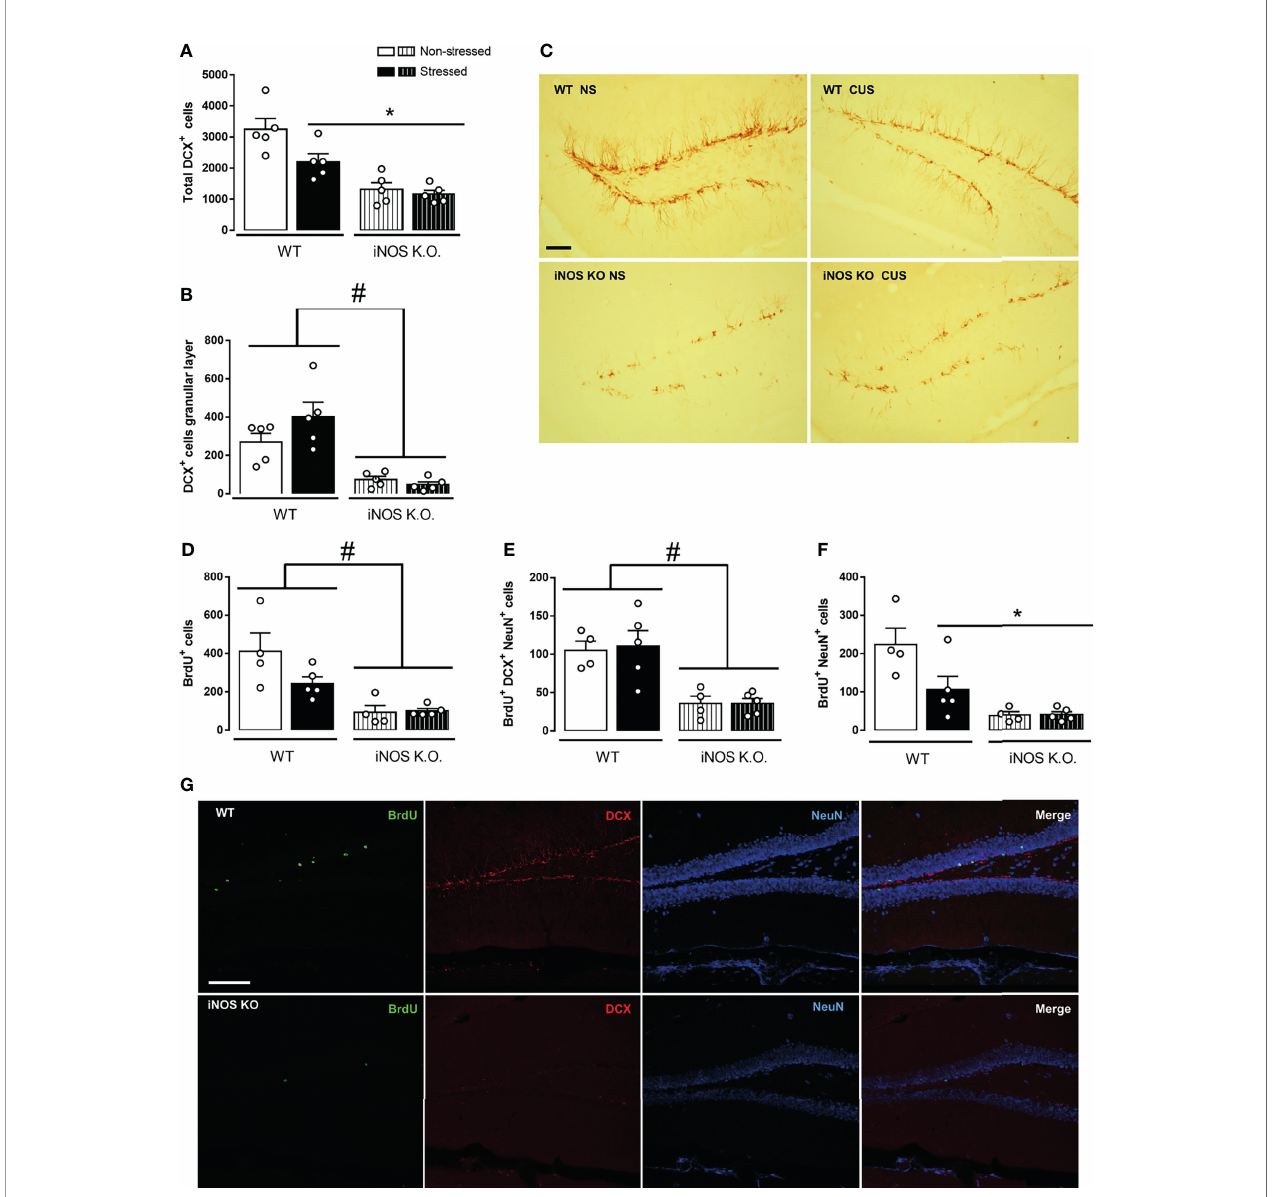
FIGURE 2 | Adult-hippocampal neurogenesis is impaired on iNOS KO mice and does not exacerbate after CUS exposure. Quanti fi cation of neuroblast revealed a reduced number and migration towards the granular layer on iNOS KO mice that did not alter after CUS [ (A, B) , respectively]. Representative image of neuroblast (DCX+ cells) on the dentate gyrus of all groups analyzed (n=5/group, scale bar = 100 µm) (C) . BrdU incorporation analysis revealed a reduced survival of adult-born new neurons on iNOS KO mice that was not affected by CUS [ (D – F) ; n = 4,5,4 and 5 respectively]. Representative images of immuno fl uorescence technique showing BrdU, DCX NeuN and Merge of markers on WT non-stress and iNOS KO non-stressed group (scale bar = 100 µm) (G) . Data present as mean ± SEM * indicates p < 0.05 compared to WT NS mice. # indicates p < 0.05 on genotype